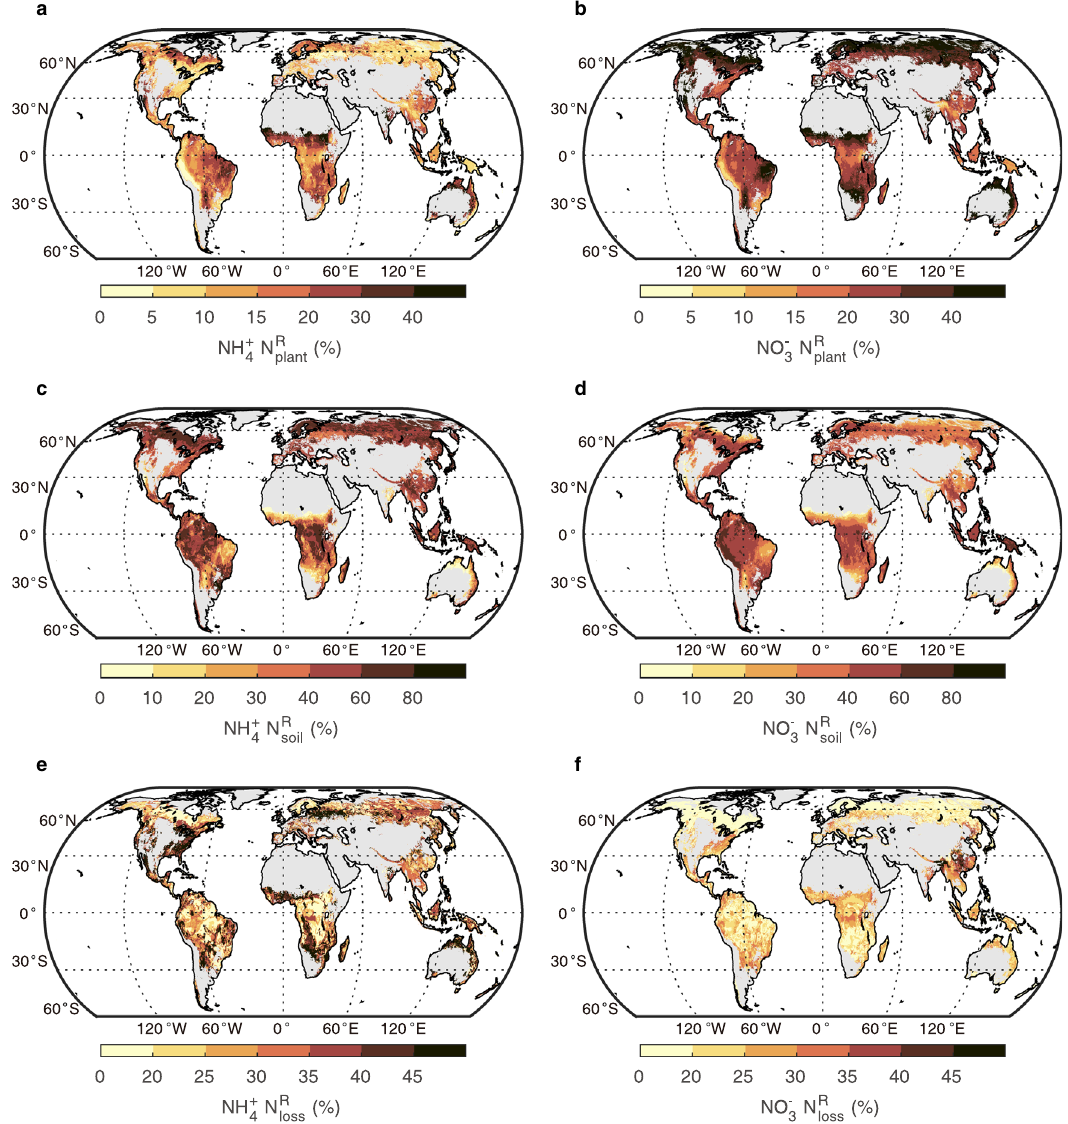
Fig. 3 Spatial patterns of estimated N retention (%) in forest plants (N R plant ) and soil (N R soil ). Figures a , c show the distribution of N retention for ammonium deposition while b , d show the distribution of N retention for nitrate deposition. Figure e , f show distribution of loss fraction ( 15 N loss ) for ammonium and nitrate depositions, respectively, and the loss fractions represents unrecovered 15 N. Nitrogen retention by plants includes both trees and understory vegetation (shrubs, herbs, and grasses) while N retention in soil includes both soil organic layer and mineral soil. The N retention in plants is further divided into retention in woody (branches, stems, and coarse roots) versus non-woody tissues as shown in Supplementary Fig.